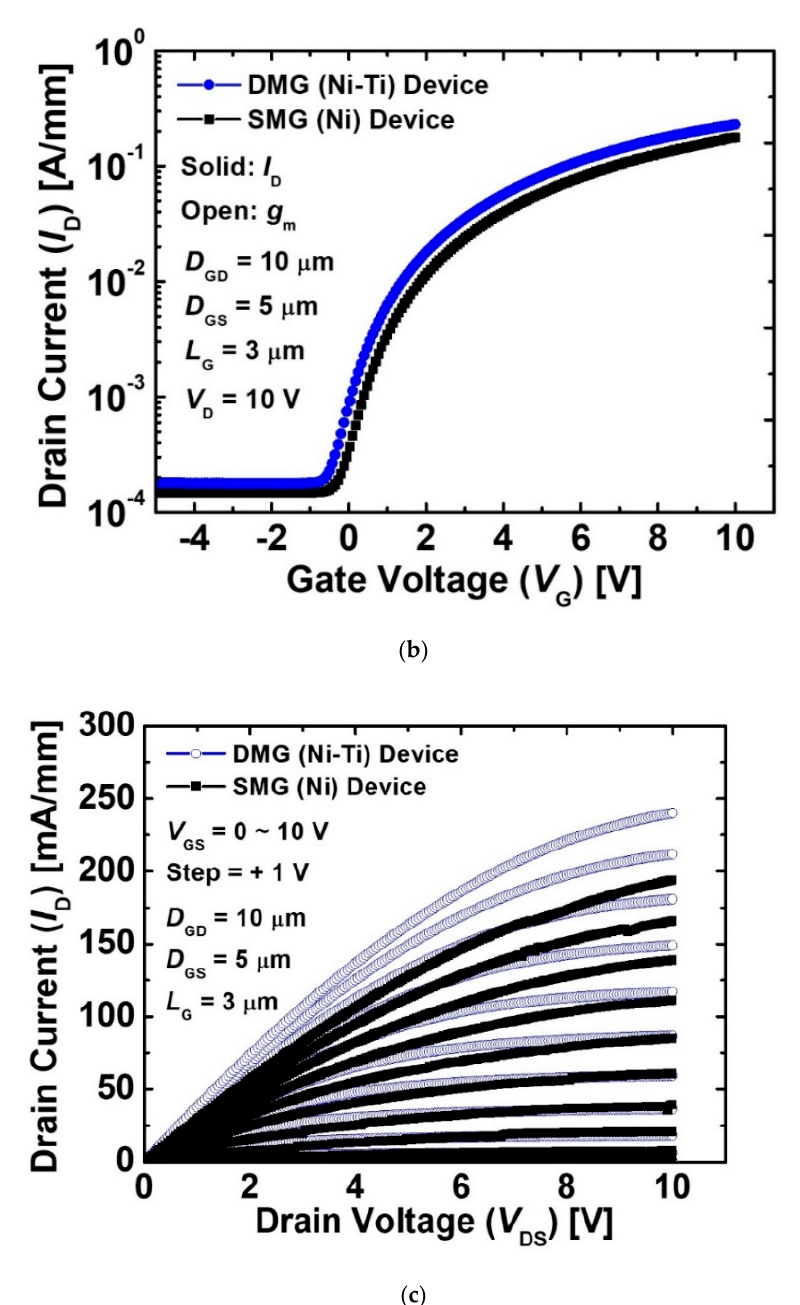
Figure 2. ( a ) Linear scale I D and g m , ( b ) logarithmic scale I D , and ( c ) output characteristics of the SMG and DMG-based devices. The L G , D GD , and D GS of both devices were 3 μ m, 10 μ m, and 5 μ m, respectively. The M1 and M2 in the DMG structure consist of Ni and Ti, respectively.